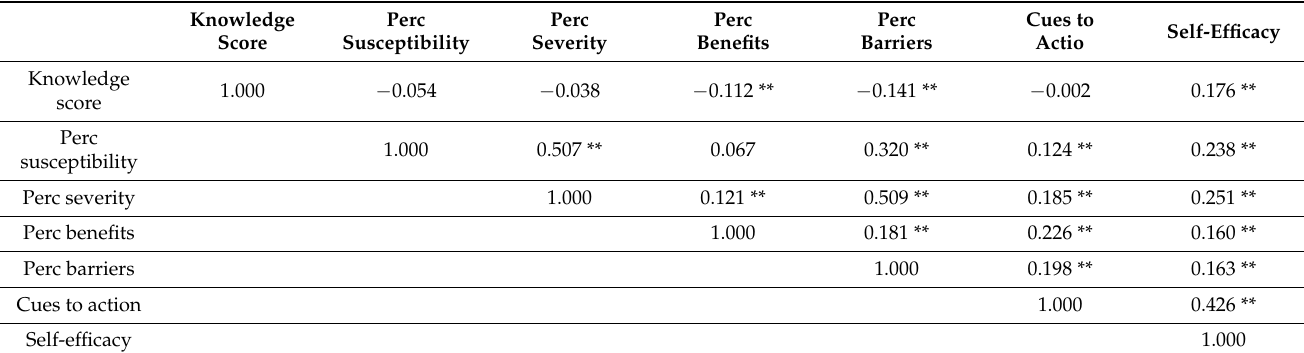
Table 4. Spearman correlation among the HBM constructs and knowledge